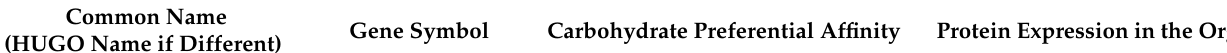
Table 8. Human M-type lectins, their carbohydrate ligands and protein expression in the